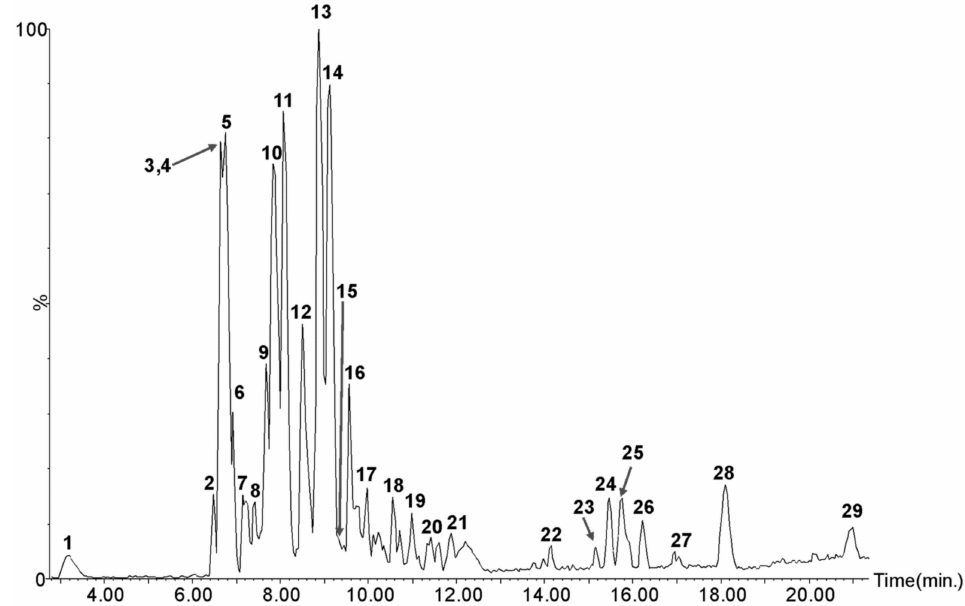
Figure 4. Ethyl acetate fraction of Azorella glabra base peak intensity (BPI)